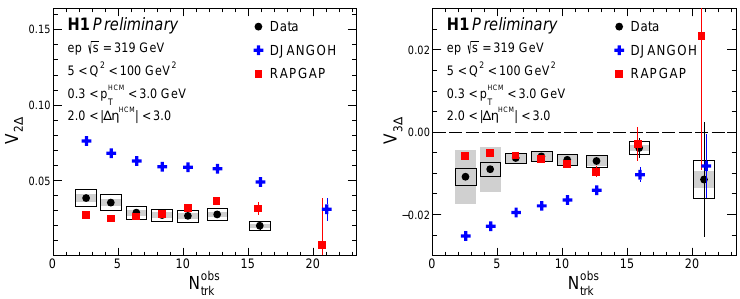
Figure 4: Anisotropies V , V versus multiplicity extracted from ep DIS 2PCs’ 1-D 2 ∆ 3 ∆ projections on ∆ φ direction. Systematic uncertainties are shown as boxes(from MC simulation) and shadows(other sources).